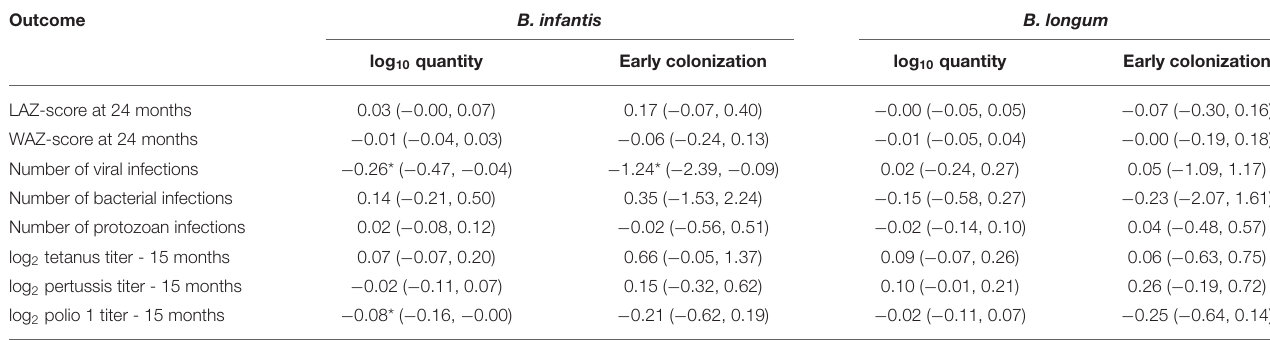
TABLE 3 | Coefficient estimates (with 95% confidence intervals) from time-fixed linear regression models of the associations between indicators of quantity and early colonization for two Bifidobacterium longum subspecies and eight outcomes in later childhood adjusted for site, WAZ-score at enrollment, socio-economic status (WAMI score) and